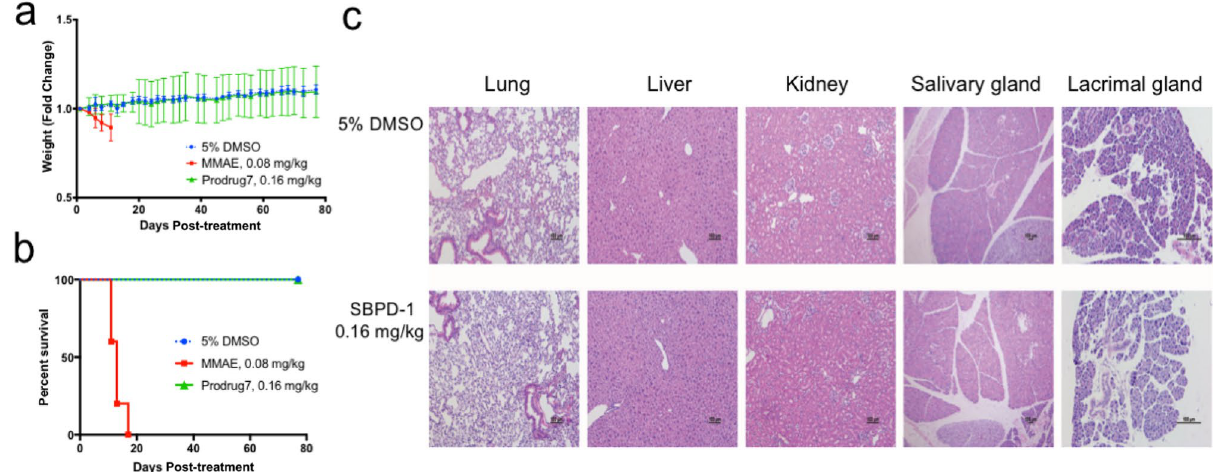
Figure 6. SBPD-1 is not toxic to healthy mice. ( a ) Changes in weight and ( b ) survival of CD-1 mice treated with the indicated drugs. ( c ) Representative histology of selected organs after the completion of the treatment with DMSO (vehicle) and SBPD-1 (scale bar 100 μm). No damage occurred within tissues (Fig. 6a). We removed lung, liver, kidneys, salivary and lacrimal glands from all tested animals at Day 80 after initiation of SBPD-1 treatment. Histopathological examination revealed no tissue damage (Fig. 6c). We also obtained peripheral blood from mice injected with vehicle, SBPD-1, and healthy untreated animals, and pre- pared serum for chemistry studies (n = 5). Blood urea nitrogen (BUN), creatinine, glucose, alkaline phosphatase (ALP), total protein (T-Pro), and alanine aminotransferase (ALT) analyses showed that animals injected with either vehicle or SBPD-1 did not show differences in these values compared with those from untreated mice (Supplementary Table S2). Complete blood counts from the mice also showed no abnormalities except for lower white blood cell count for mice injected with SBPD-1, which may have resulted from the relative instability of the cathepsin B linker in murine serum and subsequent bone marrow toxicity of MMAE 37,40 .